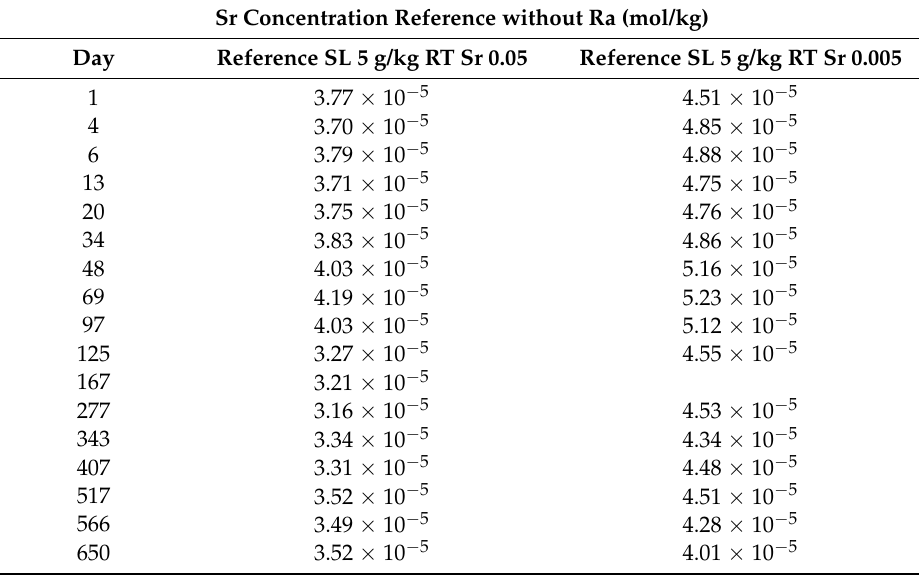
Table A14. Sr concentration of Reference experiments with Sr in the aqueous solution at 23 ◦